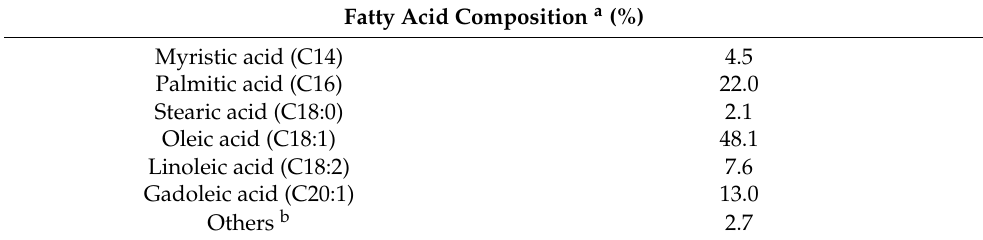
Table 3. Composition of Fatty Acid a